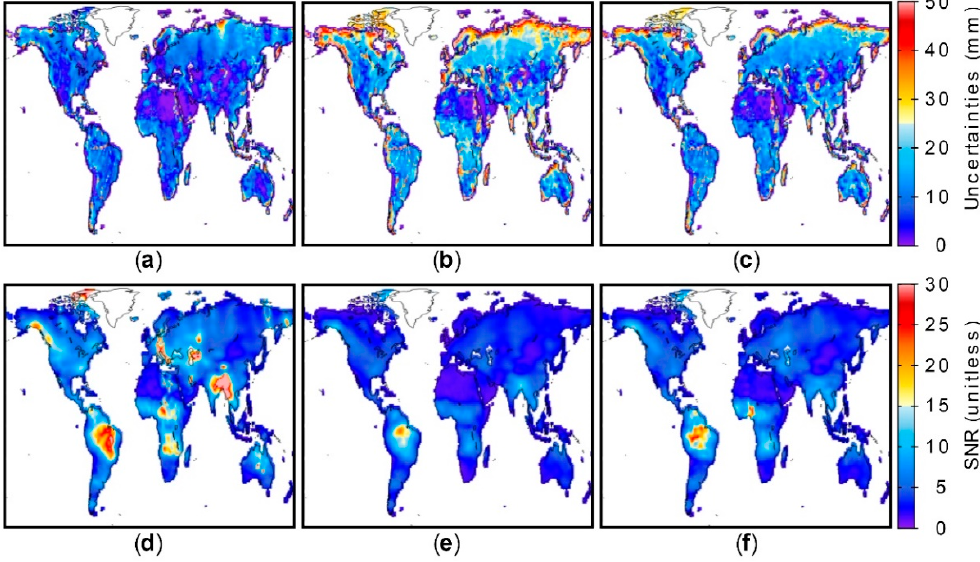
Figure 4. Uncertainty and signal-to-noise-ratio (SNR) estimates of TWS from the various processing centers CSR, GFZ, and JPL, respectively; ( a , d ), ( b , e ); and ( c , f ).